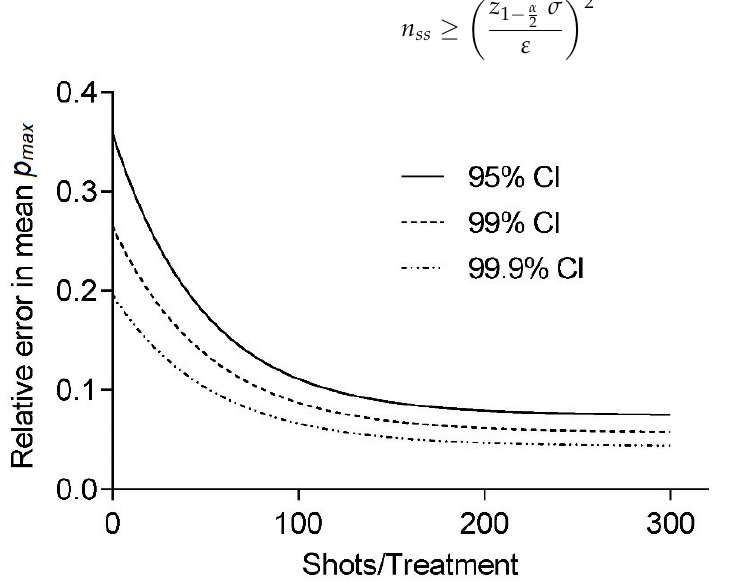
Figure 3. The estimated relative error in the mean maximum pulse pressure ( p max ) of a treatment session. Computed results for various treatment shot sizes of a Mont Carlo simulation based on an experimental probability distribution for three different confidence levels are shown.